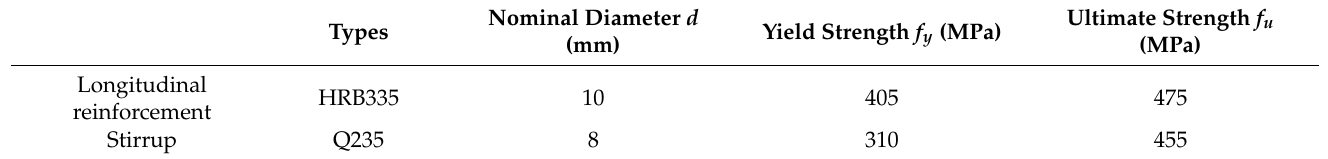
Table 2. Material properties of